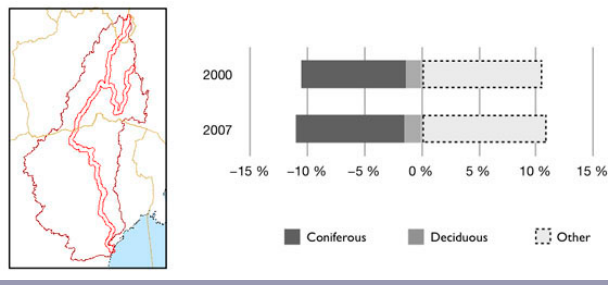
Fig. 4. Comparing land cover within a buffer of 1000 m extending from the Helge å River main flow with the land cover in the whole catchment. Forest cover in buffer underestimates forest cover in the catchment. Data from 2000 is based on classified satellite images (Kontinuerlig Naturtypskartering av Skyddad Natur [KNAS] project, Swedish EPA, unpublished data ) and data for 2007 is based on classified satellite images (Landsat) using segment-based image classification in Idrisi Taiga. Map shows catchment, buffer zone, and county borders (difference = percentage land cover in buffer - percentage land cover in whole catchment).